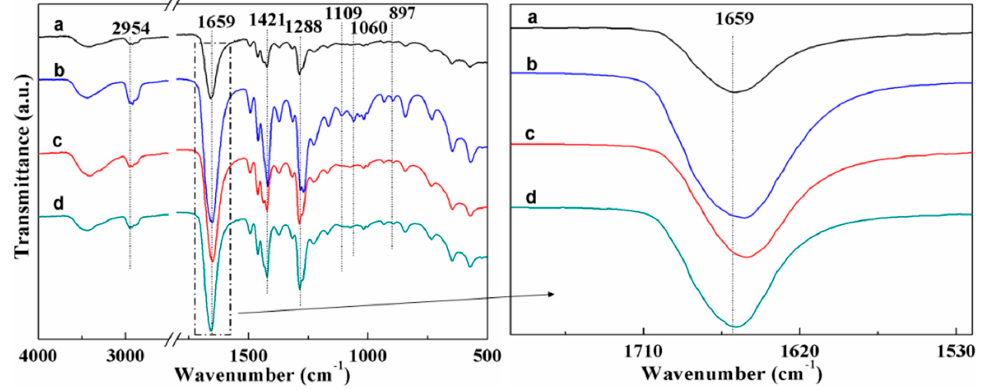
Figure 4. FTIR spectra of: ( a ) PVP; ( b ) PVP/CNC-4%; ( c ) PVP/AgNO 3 -0.34%; and ( d ) PVP/CNC-4%/AgNO 3 -0.34%.